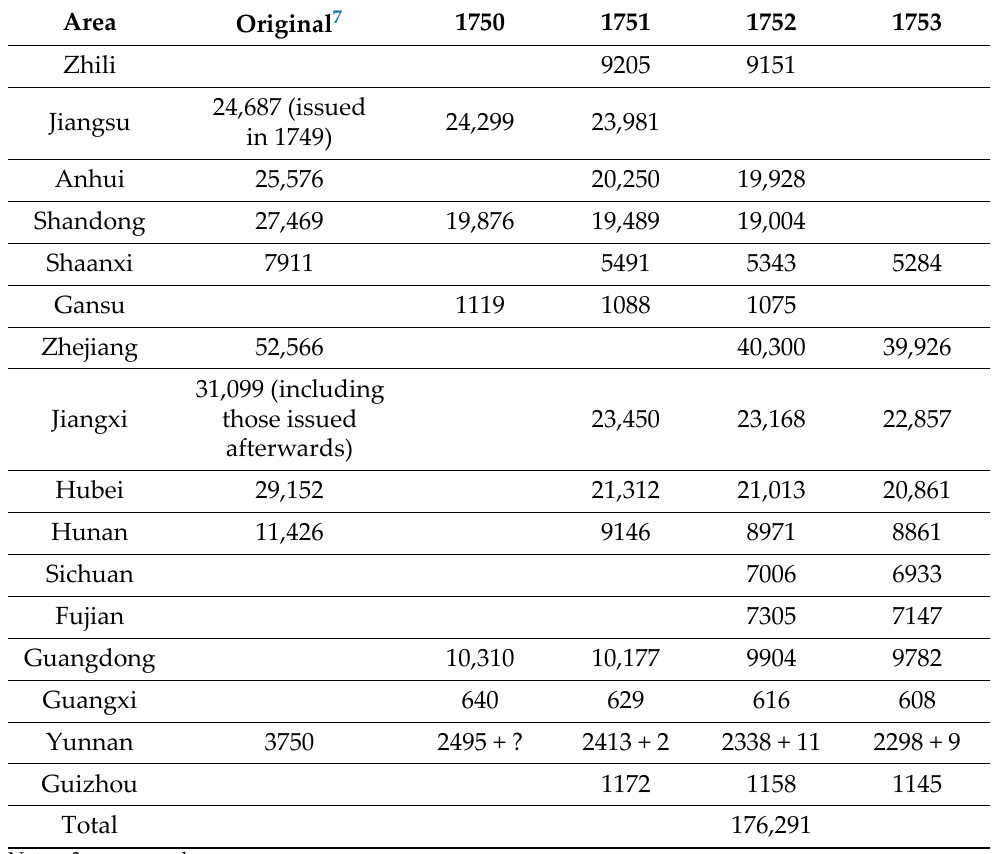
Table 2. Professor Chang’s estimated numbers of monks and Taoists in each province from 1750 to 1753.